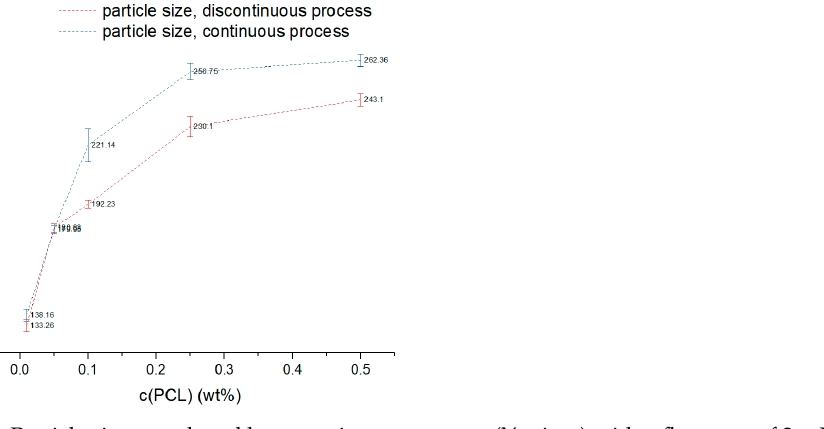
Figure 4. Particle sizes produced by a continuous process (Y-mixer) with a flow rate of 2 mL/8 mL compared to the particle sizes produced by a discontinuous process. Table 2 . Particle sizes produced by a continuous process (Y-mixer—flow rate 2 mL:8 mL) . PCL Concentration (wt%)